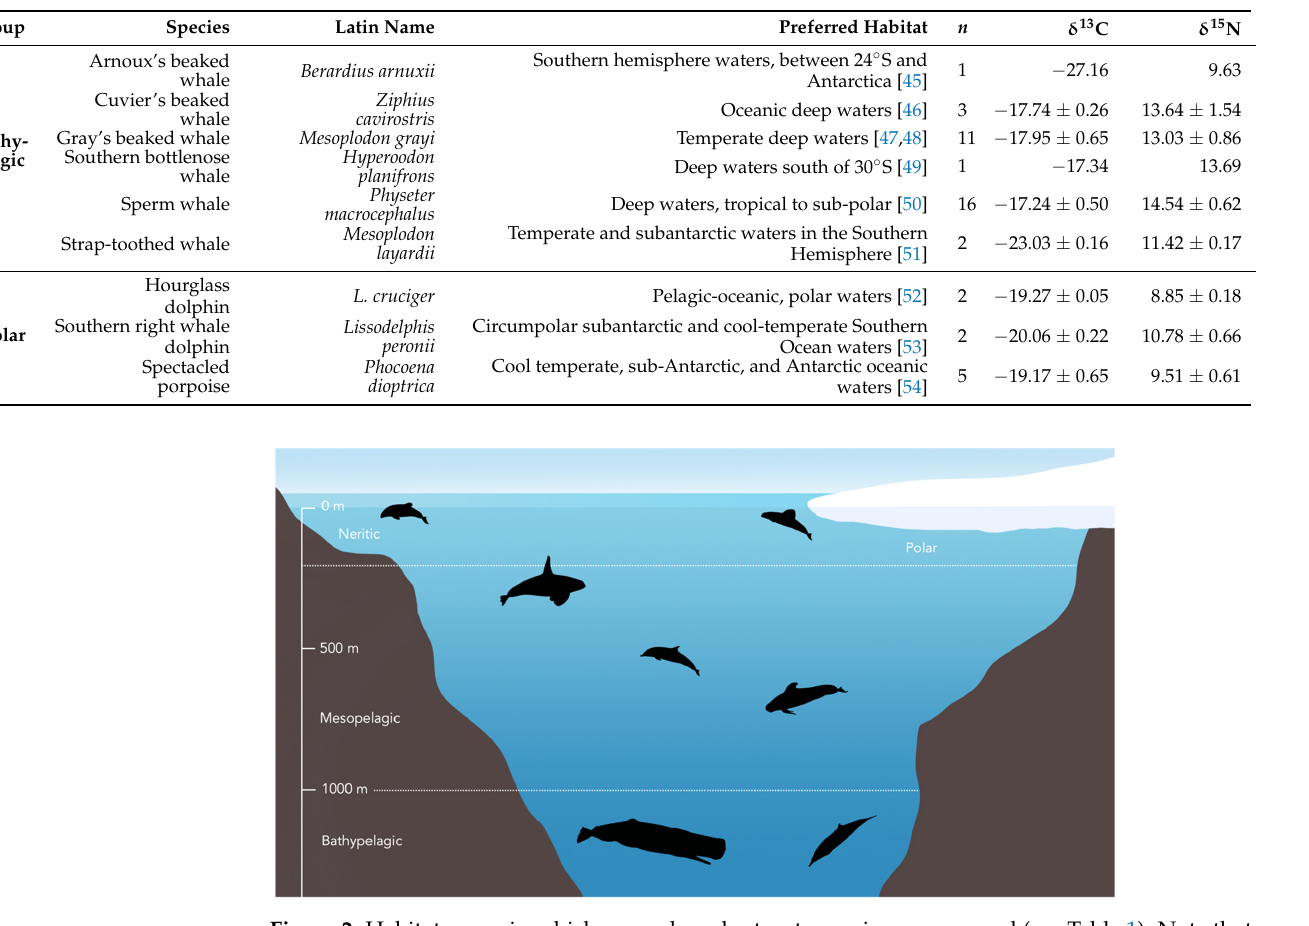
Figure 2. Habitat zones in which exemplar odontocete species are grouped (see Table 1). Note that not all species included in the study are shown here.